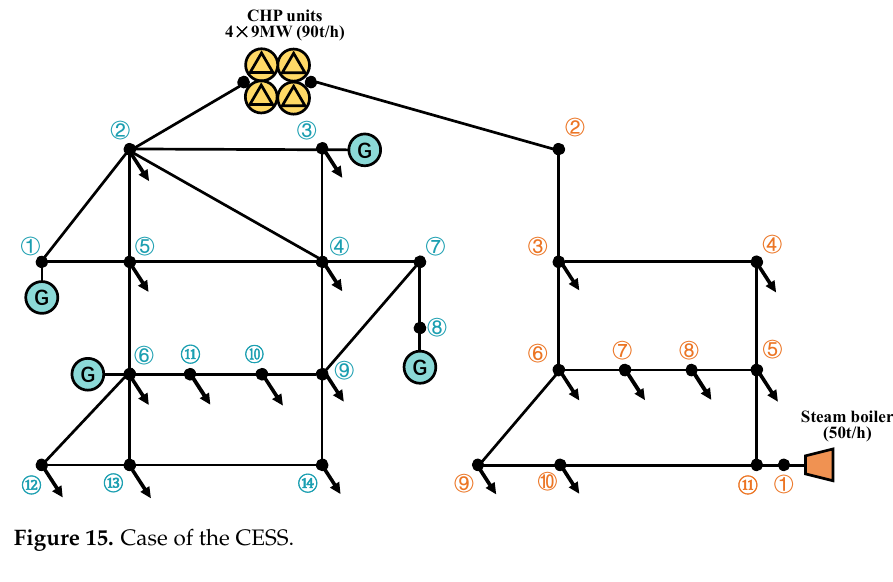
Figure 15. Case of the CESS.